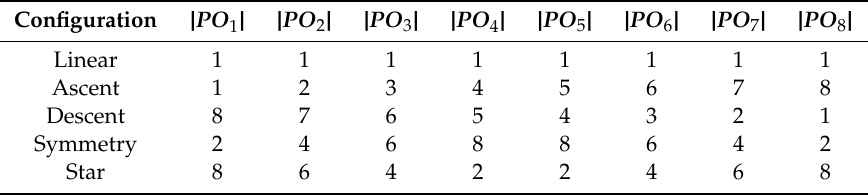
Table 3. Five configurations with low parallelism ( × 10 times for high parallelism).